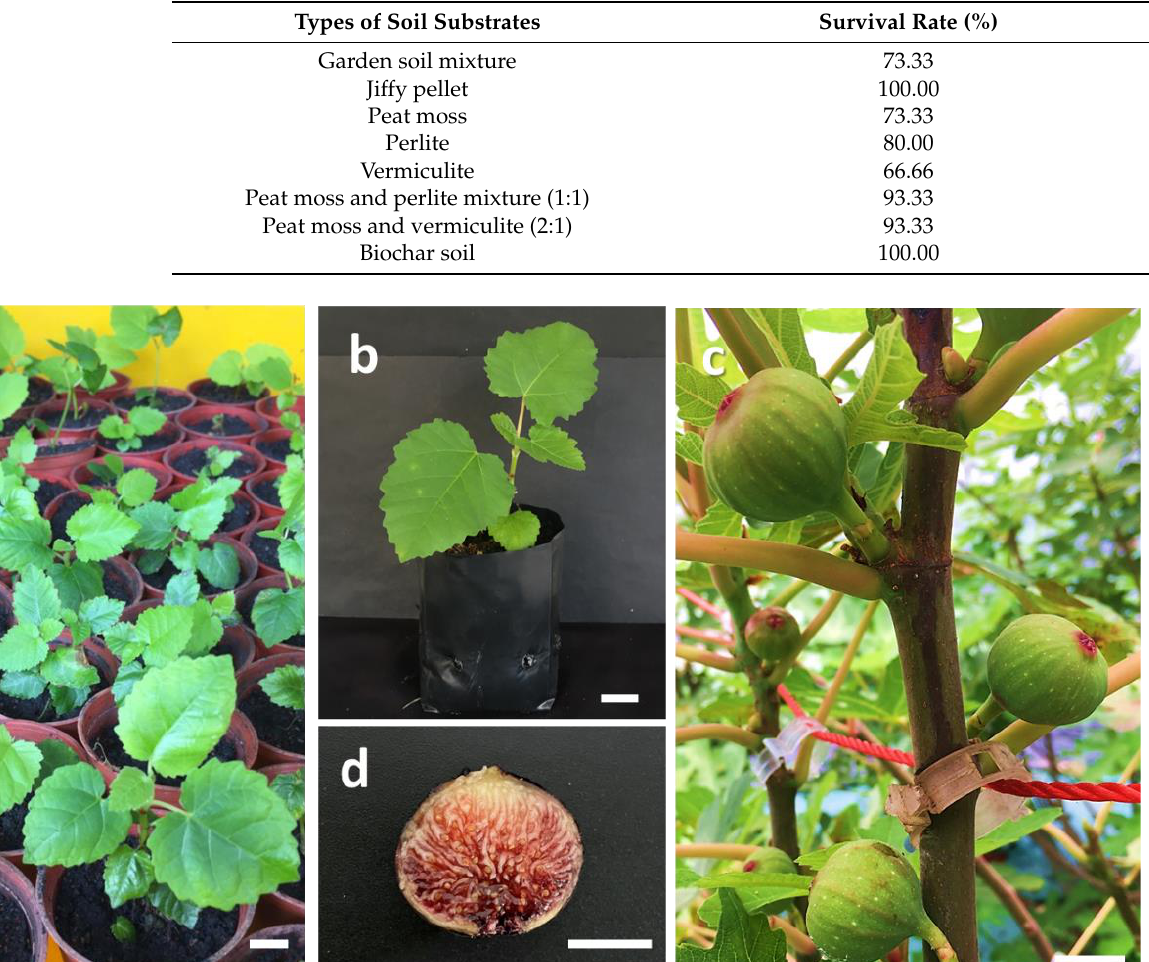
Table 3. Percentage of survival rates of rooted plantlets of Ficus carica cv. ‘Violette de Solli è s’ after 6 weeks of acclimatization in garden soil mixture (control) and different types of soil substrates.